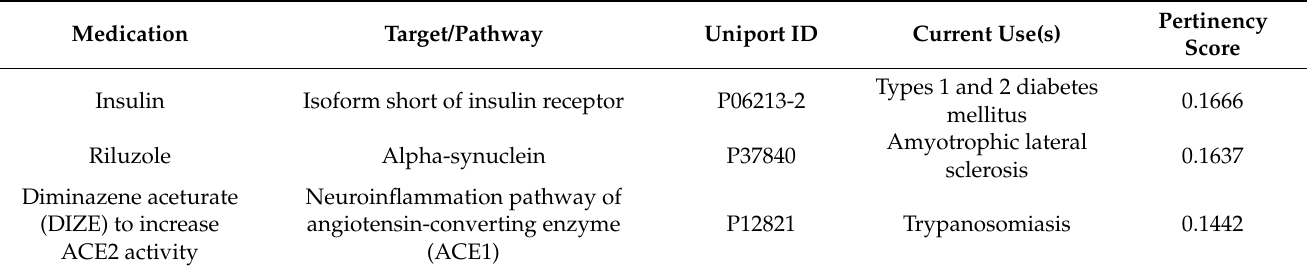
Table 3. Protein targets or biochemical pathways together with drug repositioning candidates for the possible treatment of Alzheimer’s